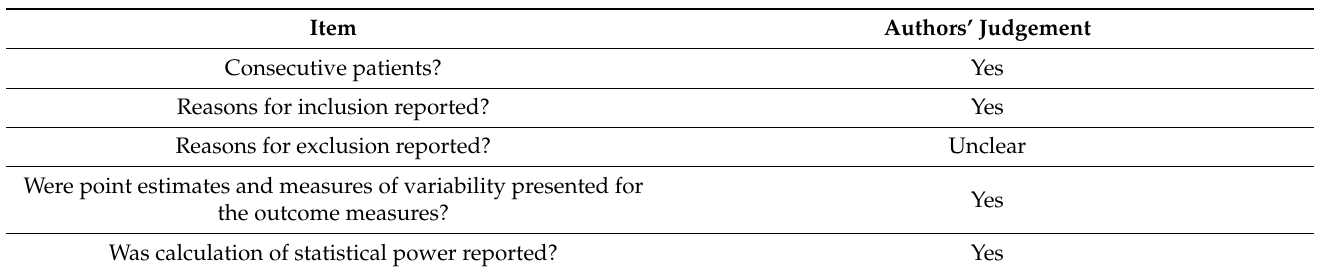
Table A5. Quality assessment.